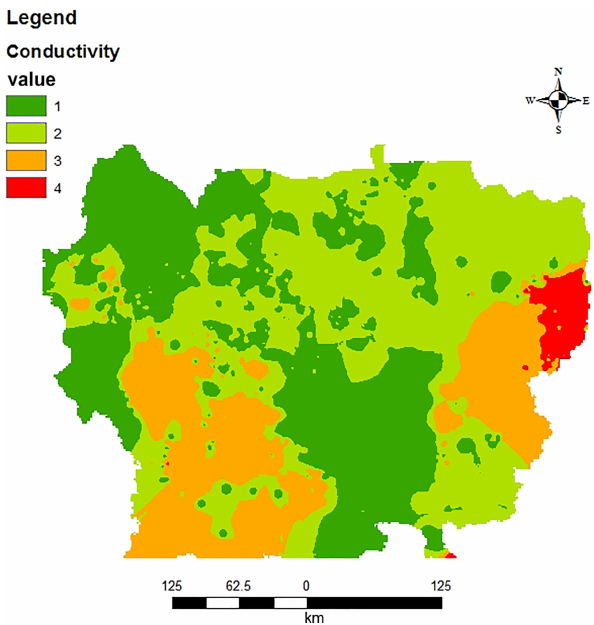
Figure 7. Hydraulic conductivity distribution